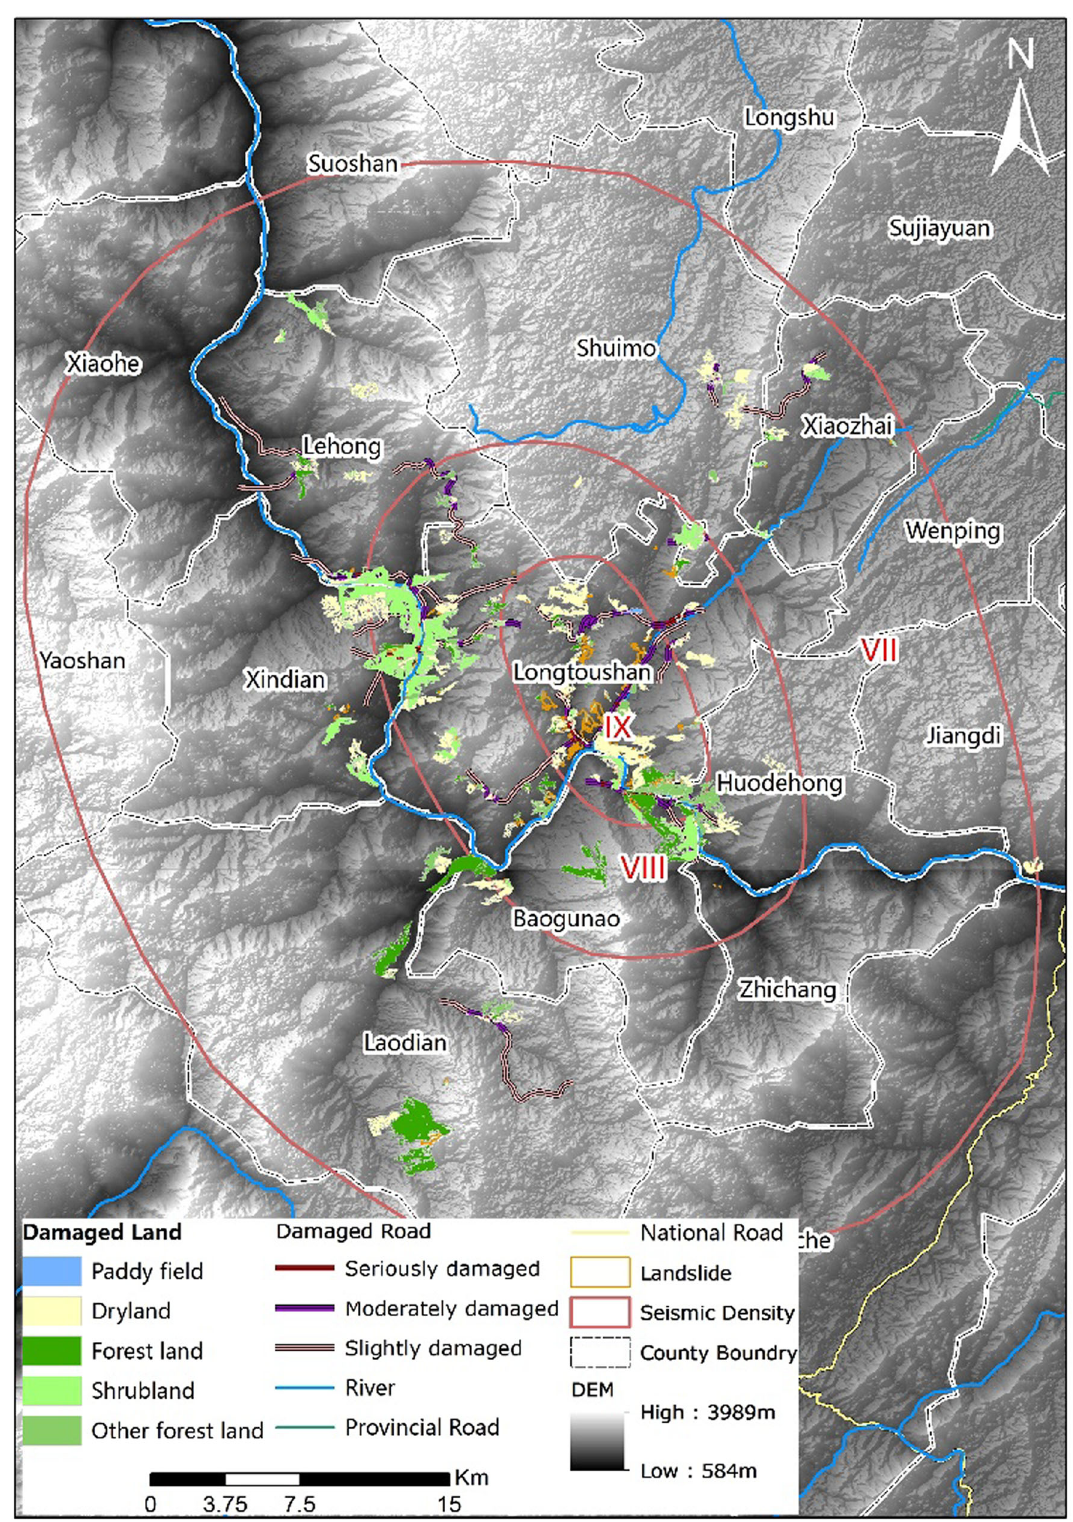
Fig. 8 Secondary geological hazards caused by the 2014 Ludian Earthquake, Yunnan Province, and road and land resource damages induced by secondary